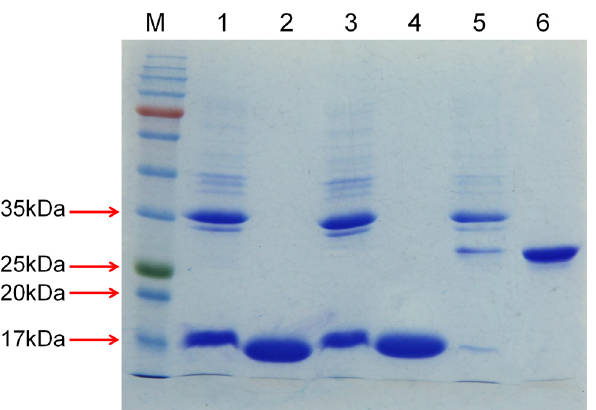
Fig 4. Detection of recombinant proteins of Ha-FAR-1, Ha-FAR-2 and Hf-FAR-1 via SDS-PAGE M: Protein marker; 1, 3, 5: Supernatant of unpurified Hf-FAR-1, Ha-FAR-1, Ha-FAR-2 respectively; 2, 4, 6: Purified Hf-FAR-1, Ha-FAR-1, Ha-FAR-2